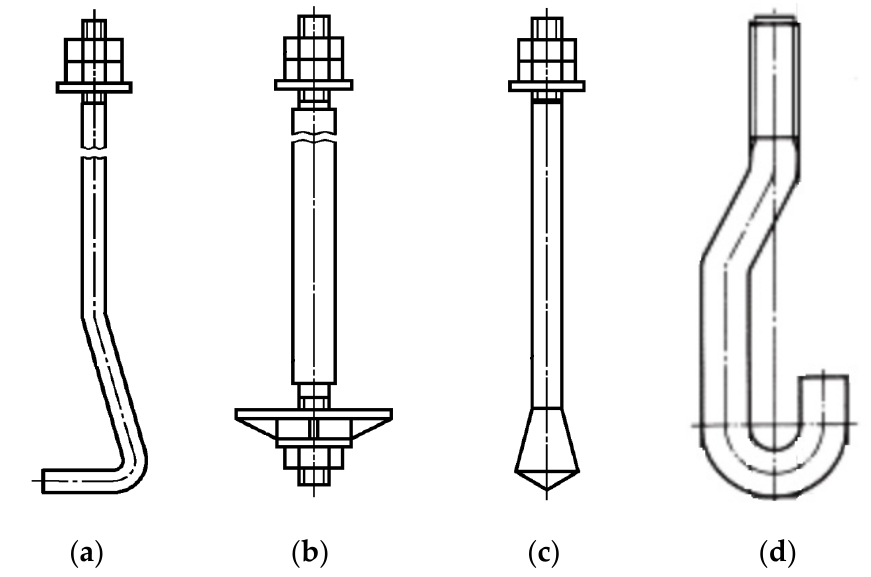
Figure 4. Cast-in-place anchors: ( a ) bent anchors; ( b ) anchors with an anchor plate; ( c ) anchors with a conical end; ( d ) anchors with a bar hook.